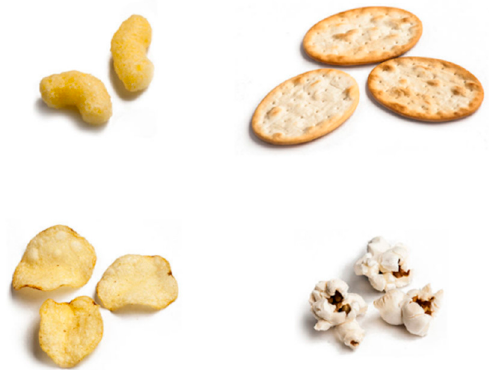
Figure 1. An example picture used to represent a Product Category. This image was used to represent the snack category. All pictures were taken by one of the authors. Table 1. The 17 treatments evaluated in this experiment. The Product Category was indicated by the first one or two letters (C for bread and pasta, M for processed meat products, P for protein supplemented products, Sa for sauces, and Sn for snacks). Sustainability Information was indicated by the letter S only if the information was provided in the treatment. The letter i indicated the Insect Presence Information only if the information was to be given. For the treatment designated 1P, the subjects saw a picture of protein supplemented products (P), with no Sustainability Information or Insect Presence Information, but for the treatment designated 9SnSi, the subjects saw a picture of snacks with both Sustainability Infor- mation and Insect Presence Information.